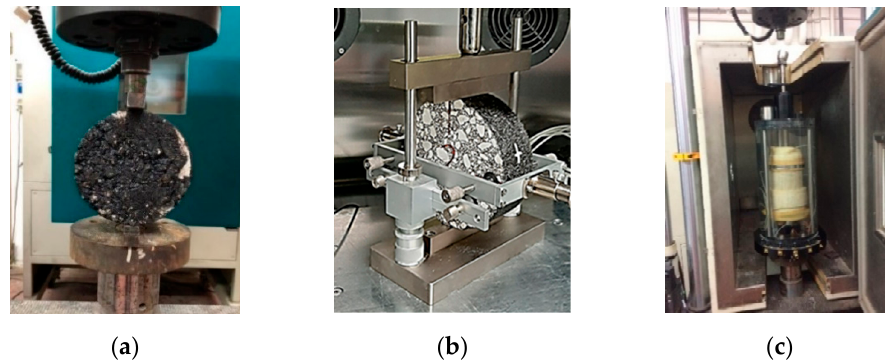
Figure 11. Asphalt mixture testing device: ( a ) ITS; ( b ) ITSM; ( c ) Cumulative strain.